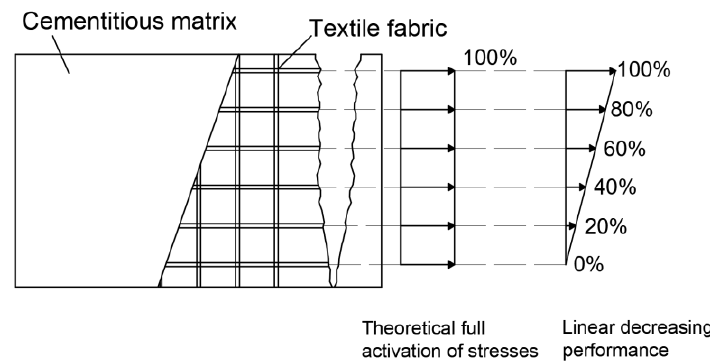
Figure 19. Theoretical and reduced distribution of stresses on basalt textile fabric.